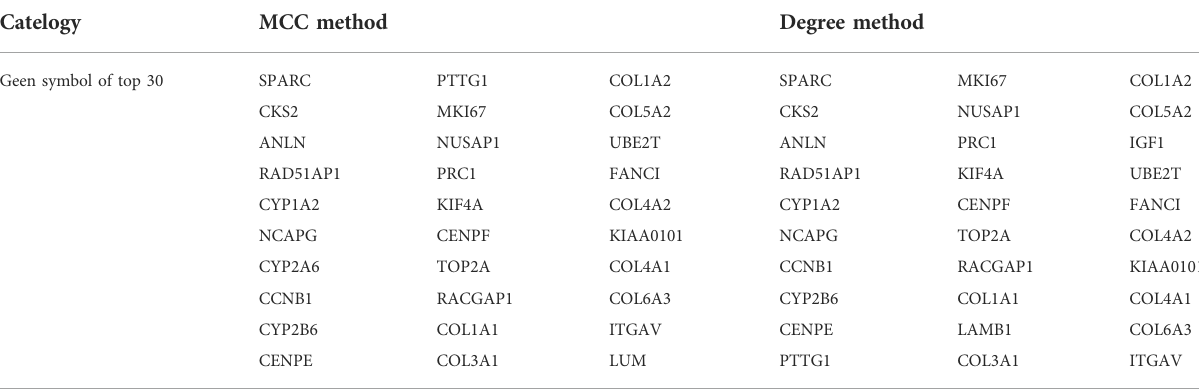
TABLE 2 Top 30 hub genes screened by MCC and Degree